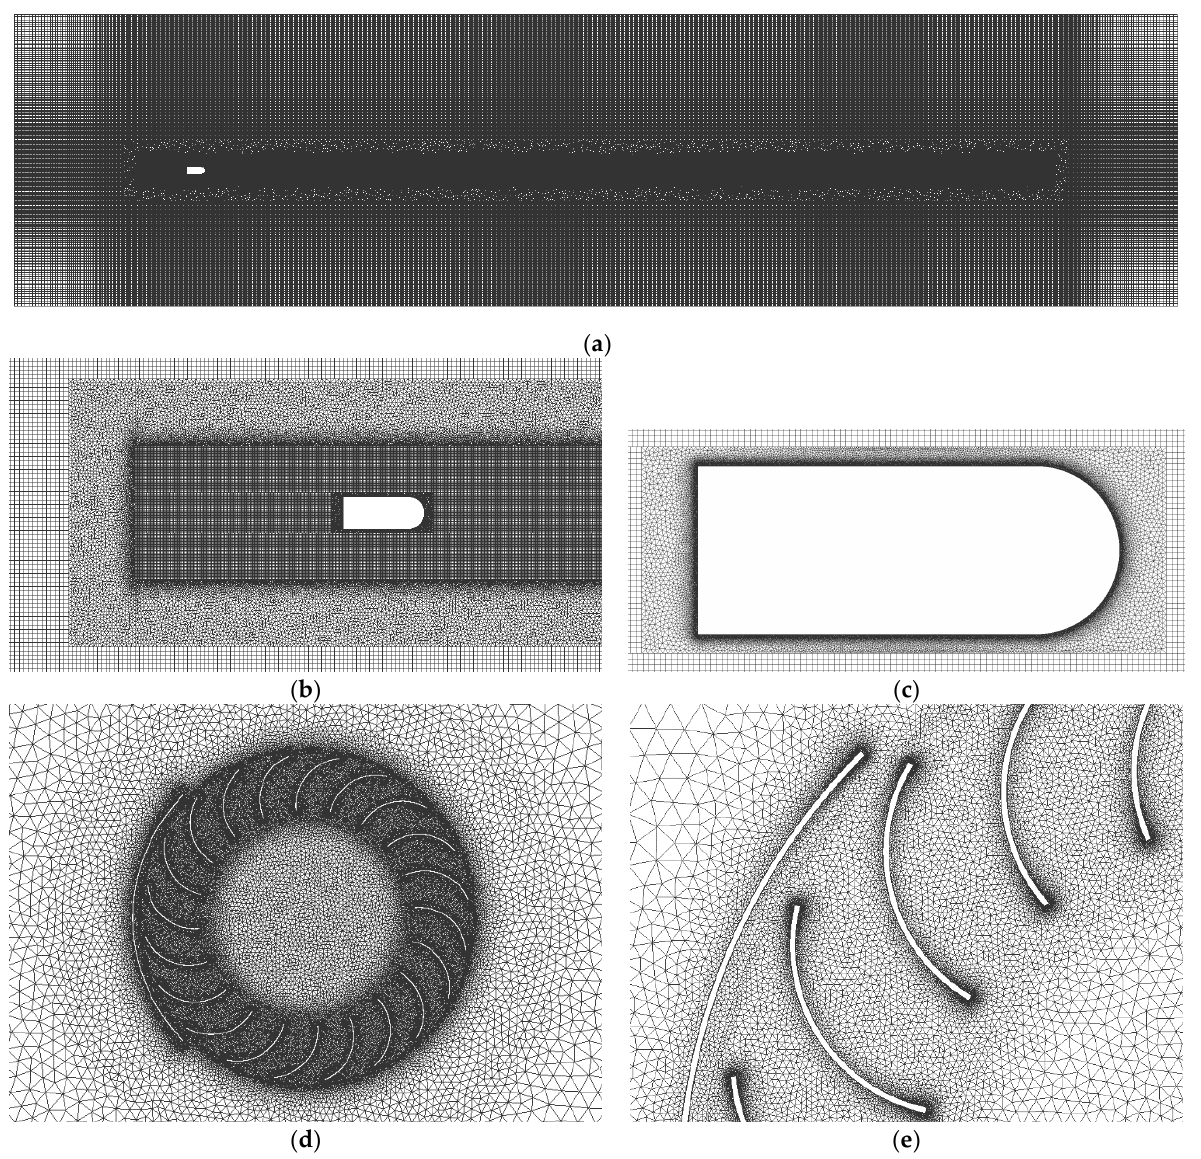
Figure 7. The mesh: ( a ) entire computational domain; ( b ) unstructured mesh surrounding layering zone; ( c ) translating zone; ( d ) rotor zone; ( e ) near blades and windshield.